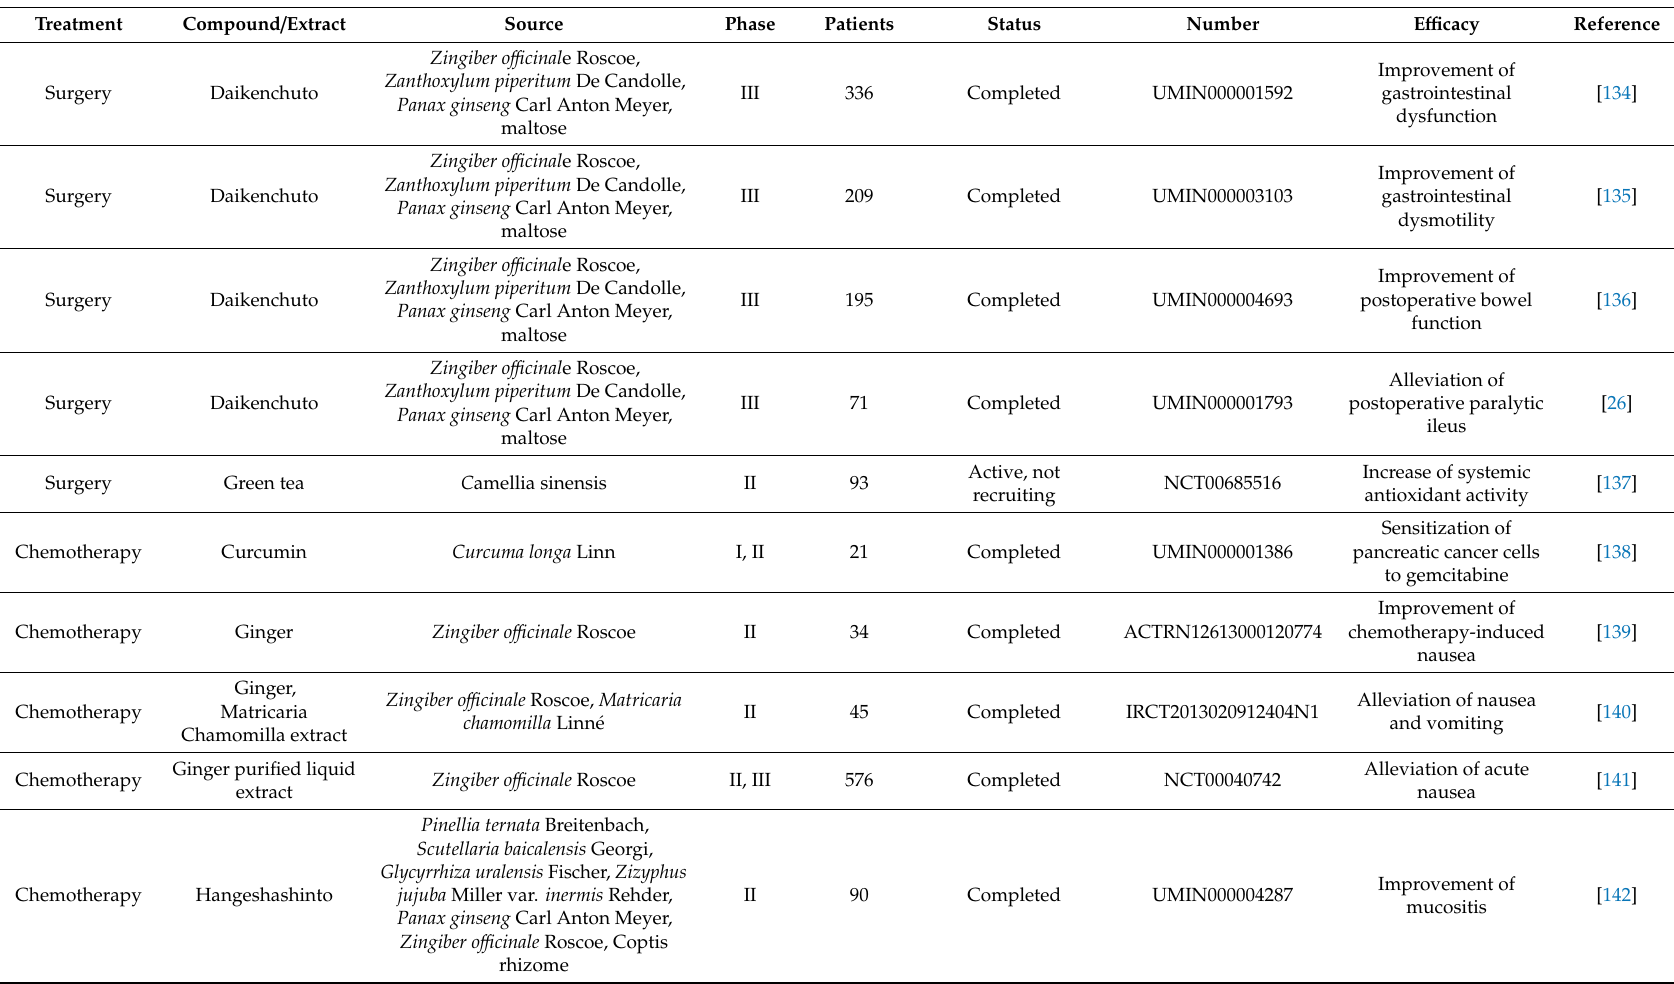
Table 5. Clinical